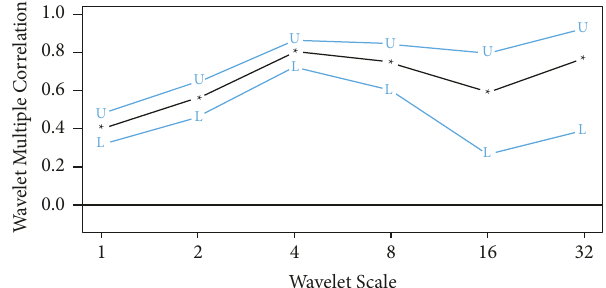
Figure 6: Wavelet multiple correlation between systematic risk of Americas (18/08/2010–03/11/2020). The blue lines denote upper (U) and lower limits (L) of the 95% confidence interval,